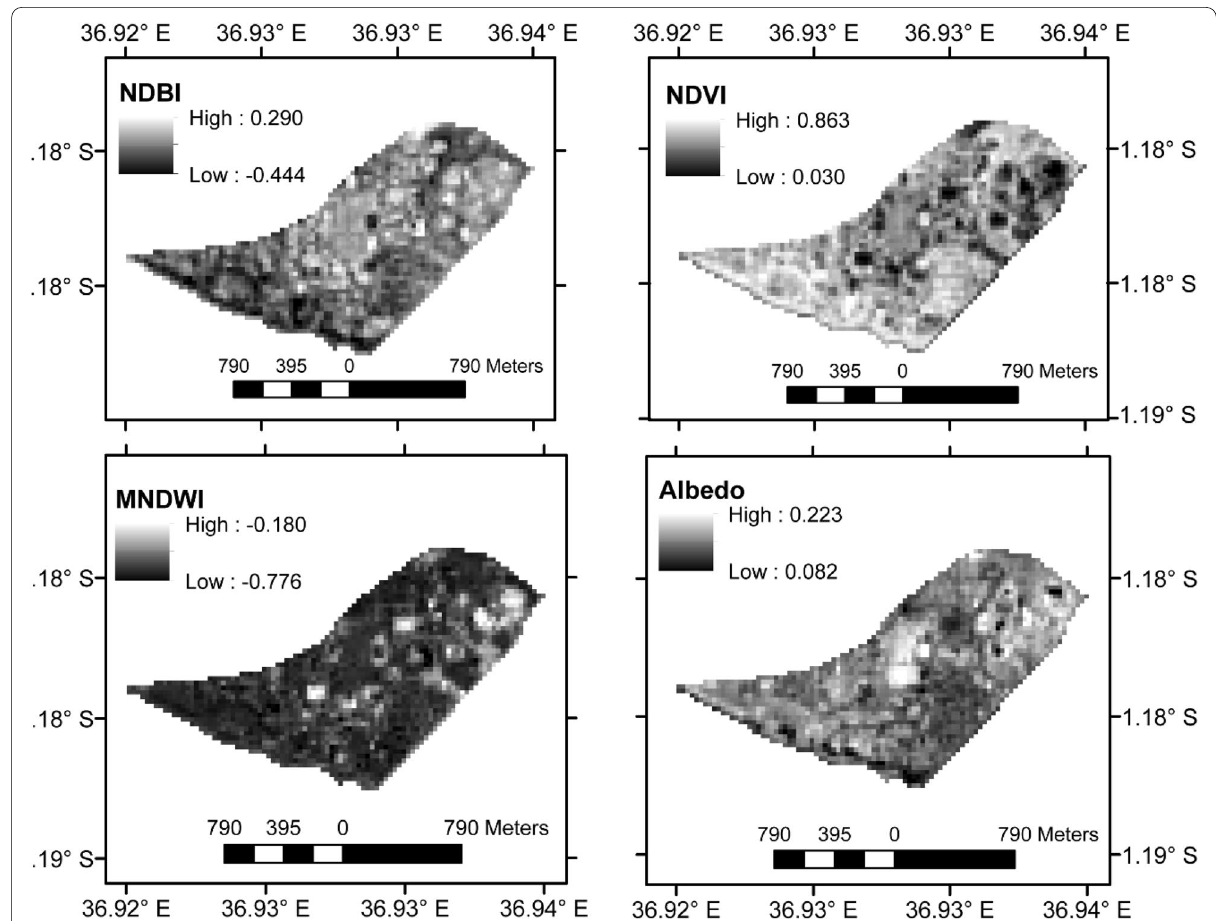
Fig. 13 Spectral indices of biophysical variables (NDBI, NDVI, NDWI, and albedo) used to explain LST and NST patterns